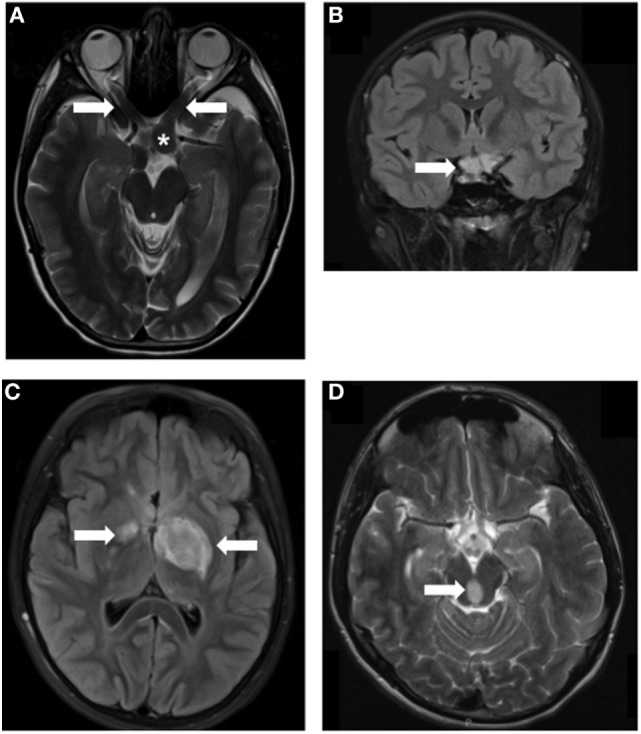
MRI images of Neurofibromatosis type 1 (NF1)-associated low-grade glioma (LGG). LGGs (arrows) developing in children with NF1 at various locations, including optic nerves (A), asterisk indicates the chiasm, chiasm (B), thalamus (C), and brainstem (D). Arrows denote the location of the tumors.